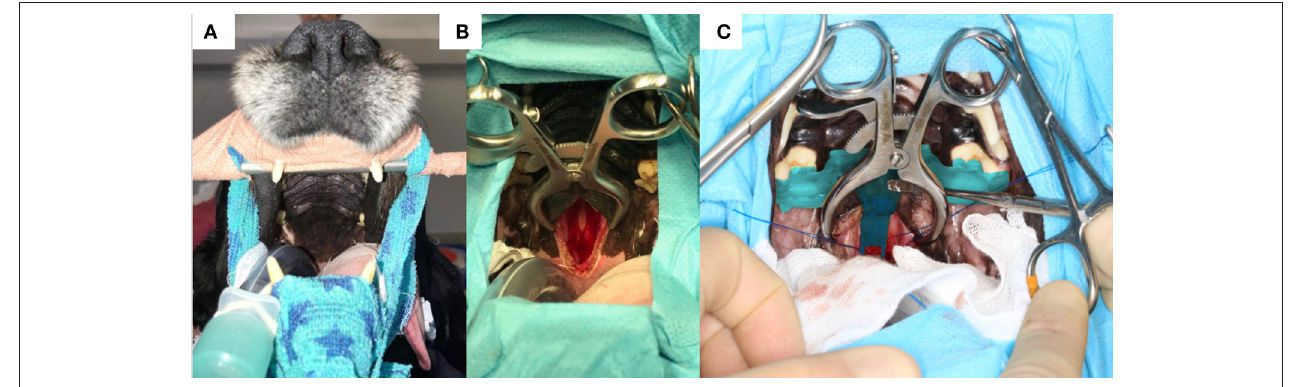
FIGURE 7 | (A) Photograph of the head of one of the dogs before surgery with the canines hooked on a bar attached to a frame and the surgical table; (B) incomplete incision in the soft palate and palatine mucosa exposing the basisphenoid bone; (C) 3-dimensional printed surgical guide in situ held by an assistant with a surgical instrument; note the foot of the guide extending toward the planned burring window; the Gelpi retractors also help to maintain the guide in place.